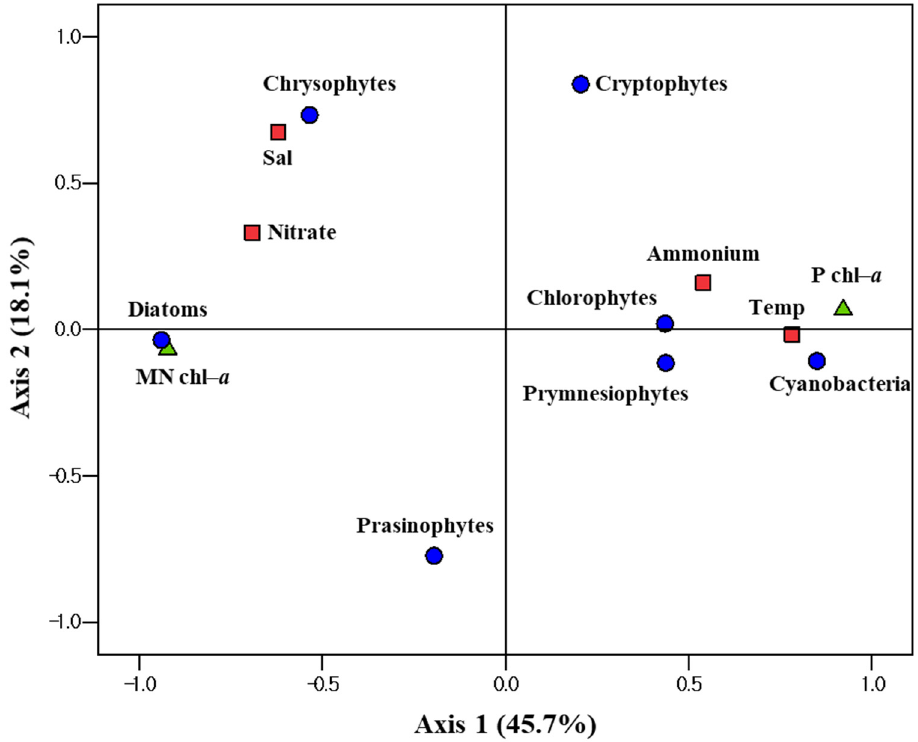
Figure 5. Principle component analysis (PCA) ordination plots of axes 1 and 2 showing the phytoplankton community structure in relation to physical (temperature and salinity), chemical (nitrate and ammonium), and biological (size-fractionated chlorophyll- a ) environmental variables in the YS and ECS during late summer of 2020. Temp: water temperature; Sal: salinity; MN chl- a : sum of the ratio of micro- and nano-sized chlorophyll- a concentration to total chlorophyll- a concentration; P chl- a : ratio of pico-sized chlorophyll- a concentration to total chlorophyll- a concentration.